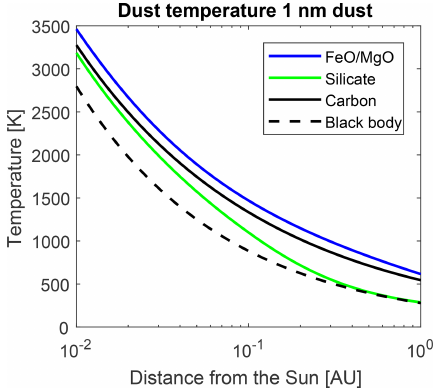
Figure 7. Temperature of 1nm dust particles as a function of dis- tance; line colour indicates dust